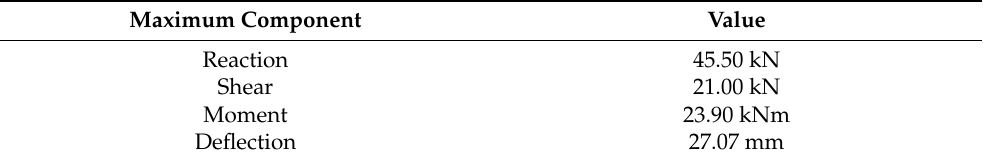
Table A3. Double-span beam load table for 2.27 kPa.